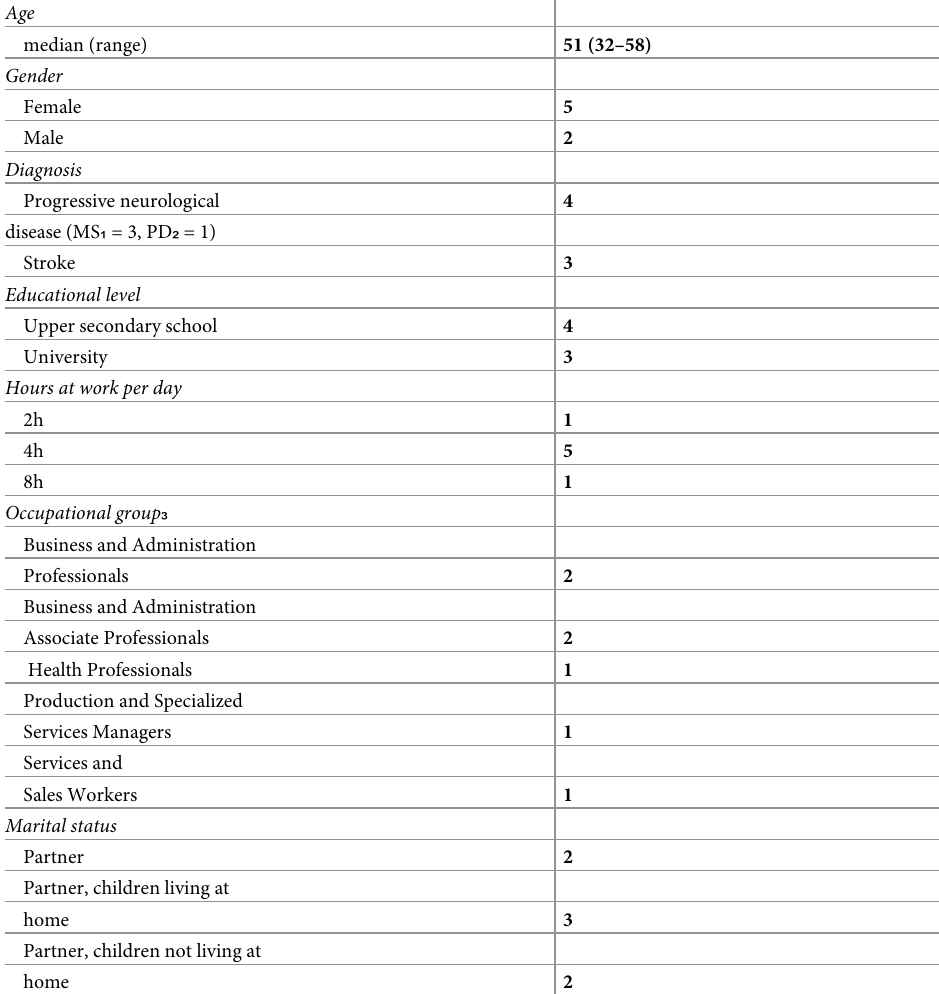
Table 1. Characteristics of the participants, n =